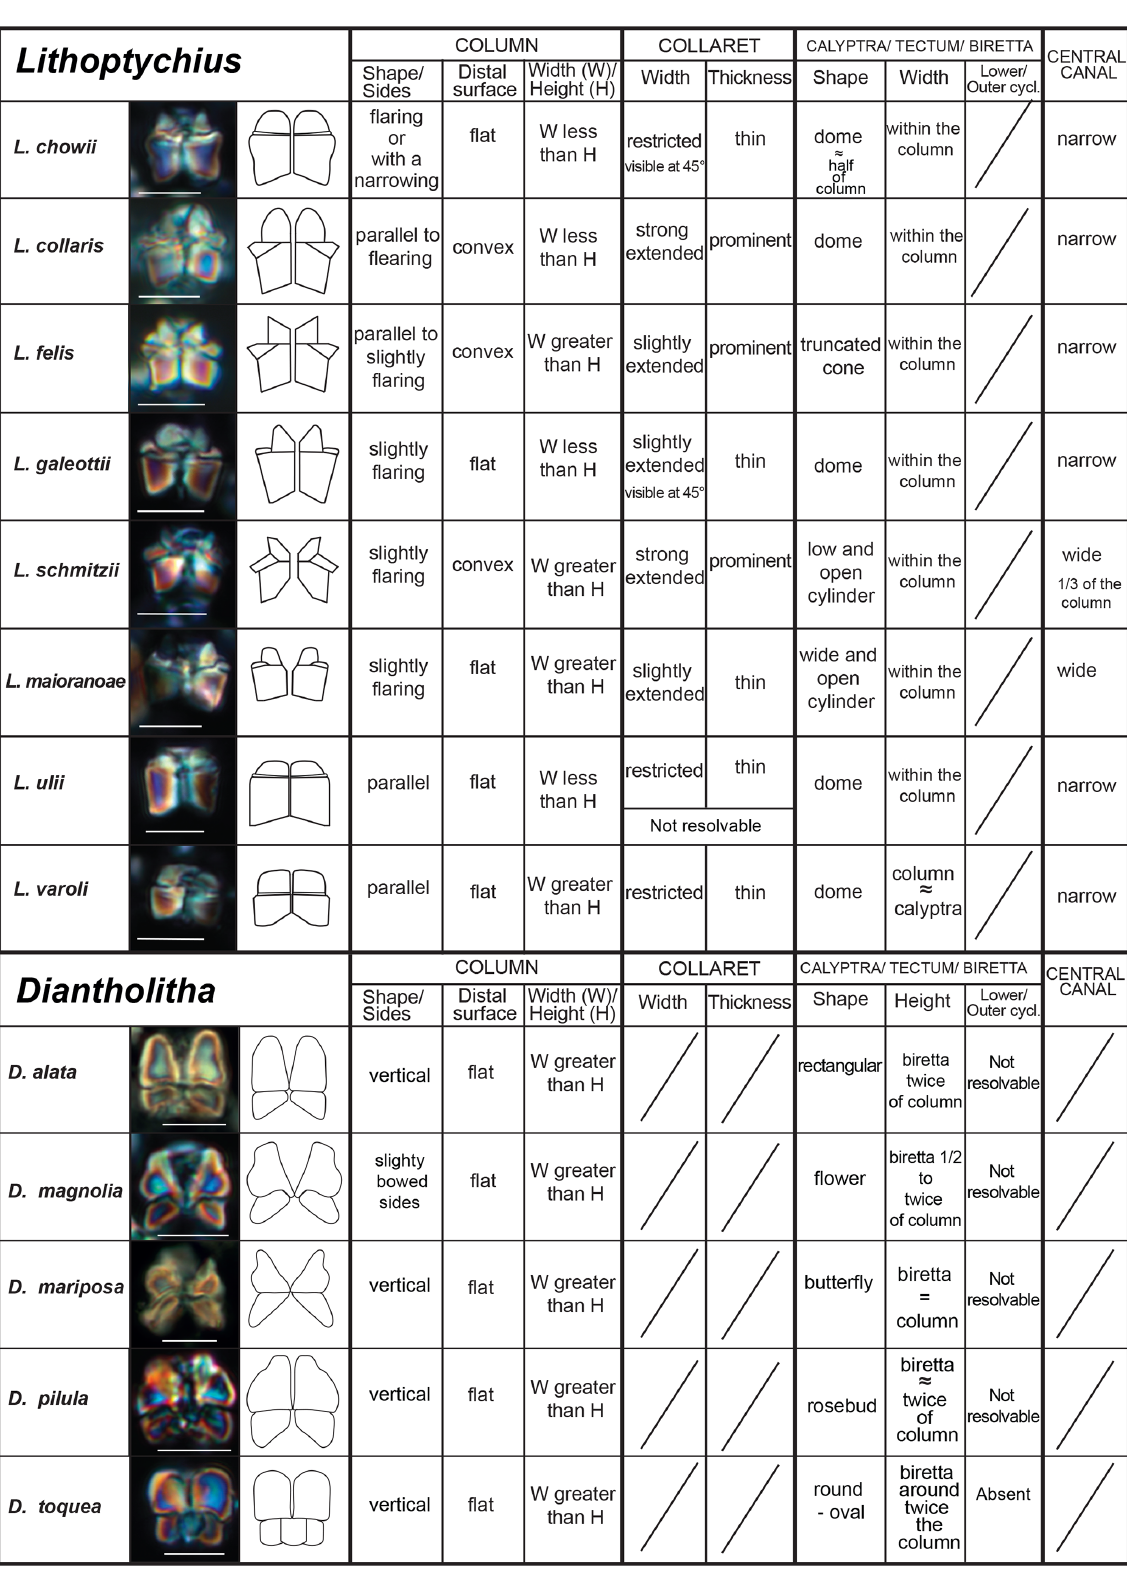
J. Micropalaeontology, 40, 101–144,